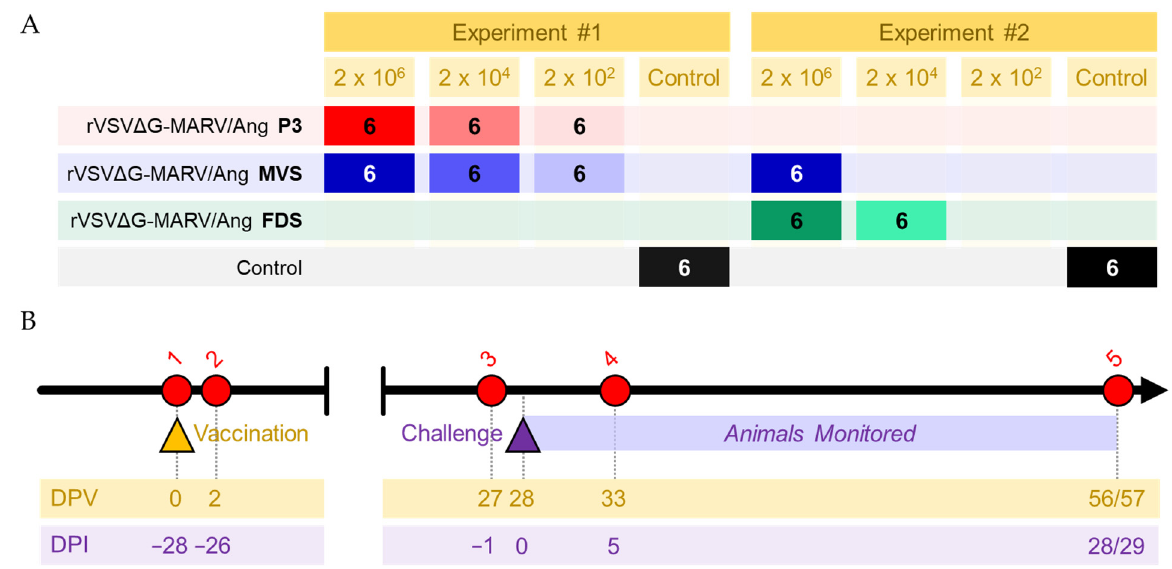
Figure 1. Study outline. ( A ) Groups of six guinea pigs were vaccinated with rVSV Δ G-MARV P3, PHV01 MVS, or PHV01 FDS at one of three doses, 2 × 10 6 PFU (high), 2 × 10 4 PFU (medium), or 2 × 10 2 PFU (low). Control animals were injected with an equal volume of 0.9% saline. The study was conducted in two independent experiments, with rVSV Δ G-MARV P3 and PHV01 MVS evaluated in Experiment #1 and PHV01 MVS and PHV01 FDS evaluated in Experiment #2. ( B ) Twenty-eight days later, all animals were challenged with 1000 LD 50 guinea-pig-adapted MARV variant Angola and monitored for signs of disease. Blood samples were obtained from each animal at the following time points: (1) prior to vaccination at 0 days postvaccination (DPV) or − 28 days post-infection (DPI); (2) 2 DPV or − 26 DPI; (3) 27 DPV or − 1 DPI; (4) 33 DPV or 5 DPI; (5) 56/57 DPV or 28/29 DPI.